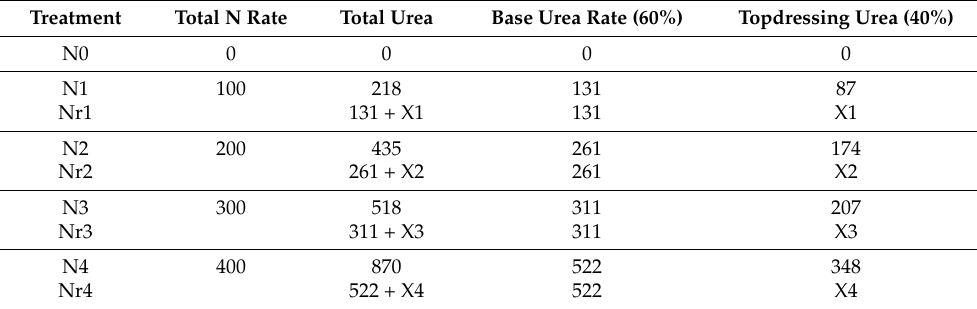
Table 1. Nitrogen application rates (g·plant − 1 ) for different treatments.